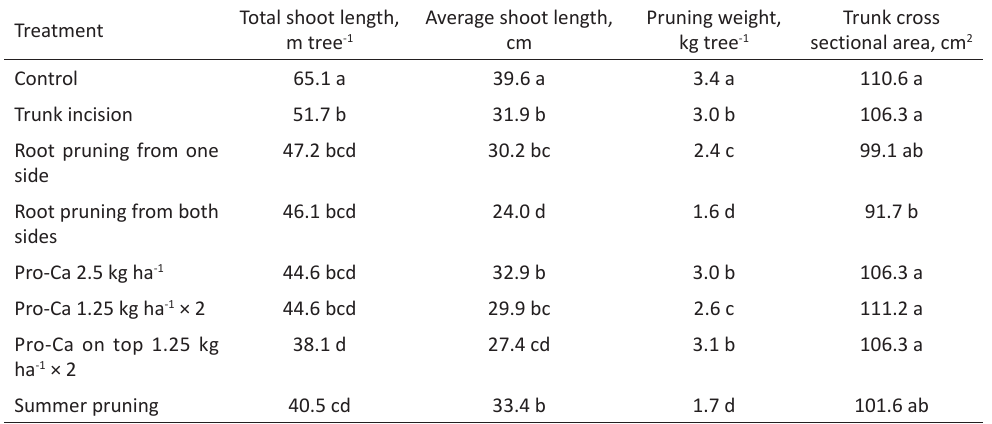
Table 1. Effect of growth control technologies on growth parameters of apple cv. ‘Rubin’, average of 2015–2018